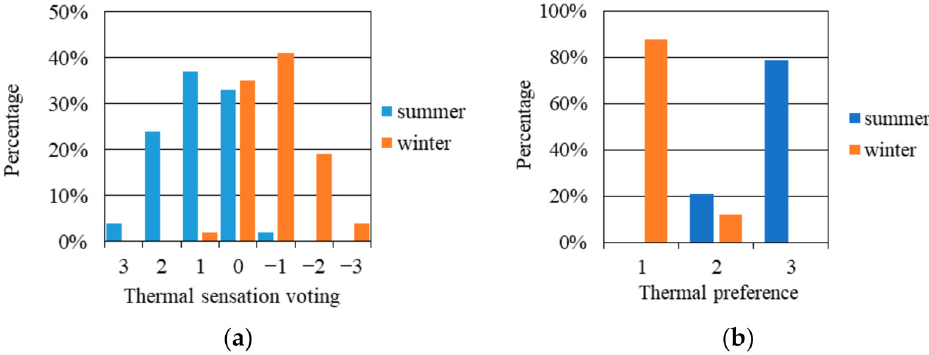
Figure 2. Survey results on thermal comfort: ( a ) thermal sensation voting; ( b ) thermal